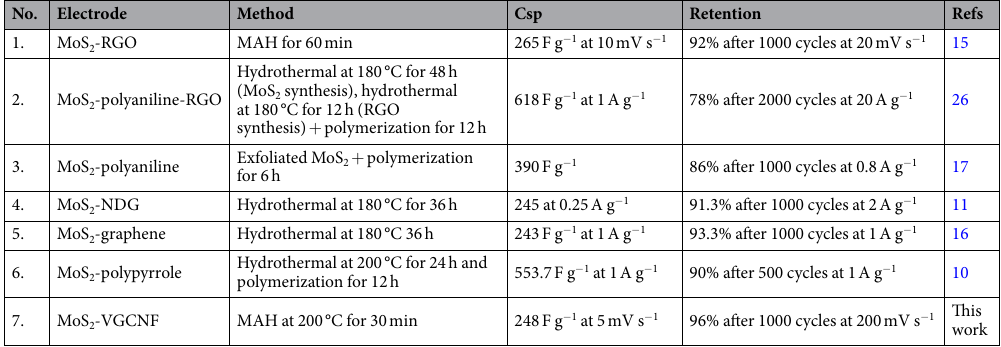
Table 2. Comparison of electrochemical performance of MoS 2 composite